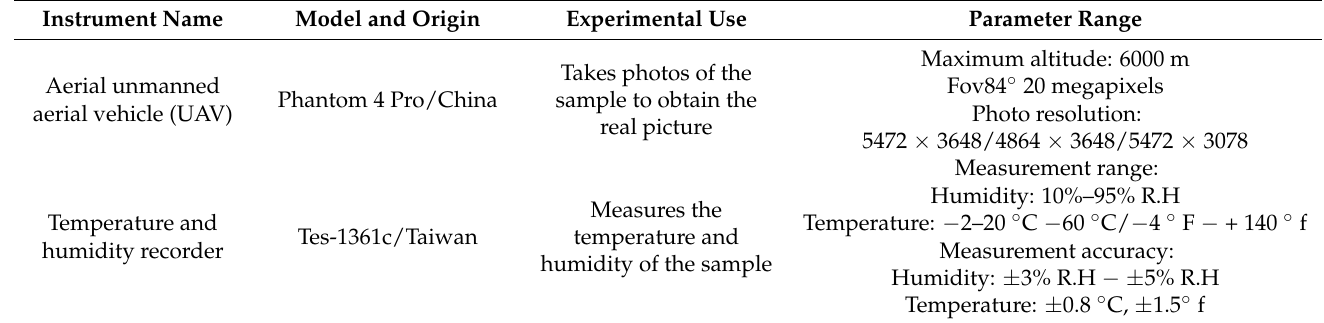
Table 2. List of experimental instruments.